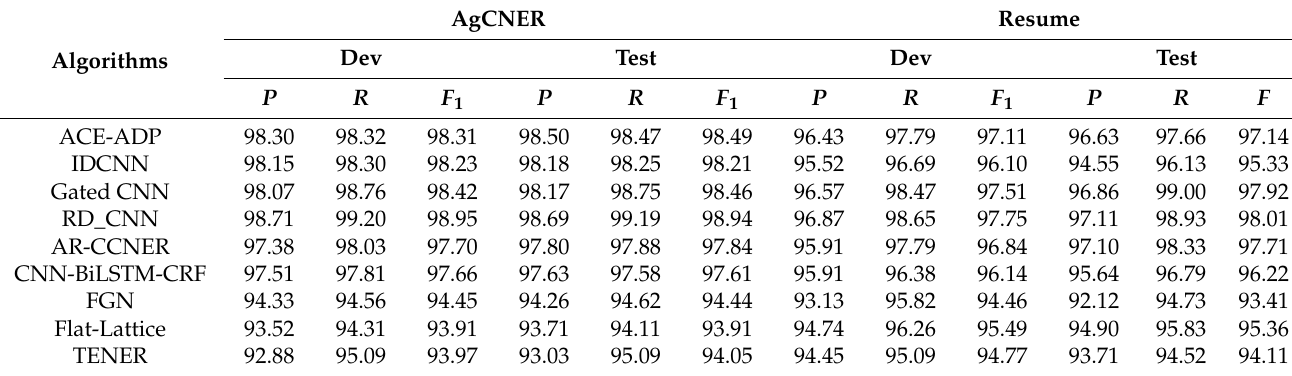
Figure 7. The training and validation losses for ( a ) Word2vec-BiLSTM-CRF, ( b ) BERT-BiLSTM-CRF, and ( c ) ACE-ADP on the AgCNER dataset.